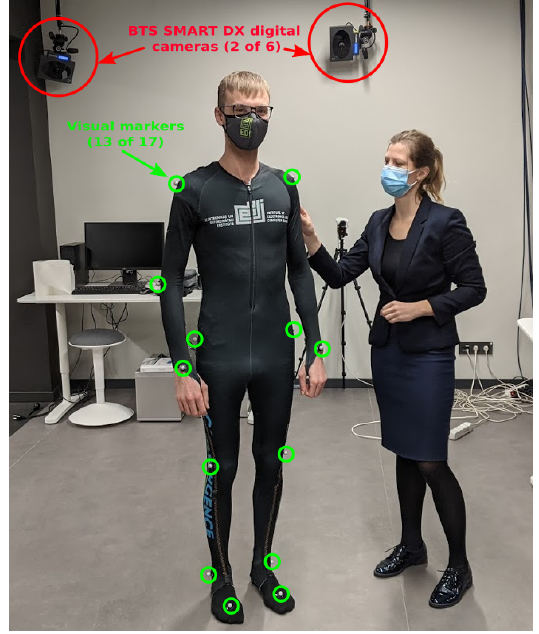
Figure 9. The sensor clothing testing environment with BTS SMART DX